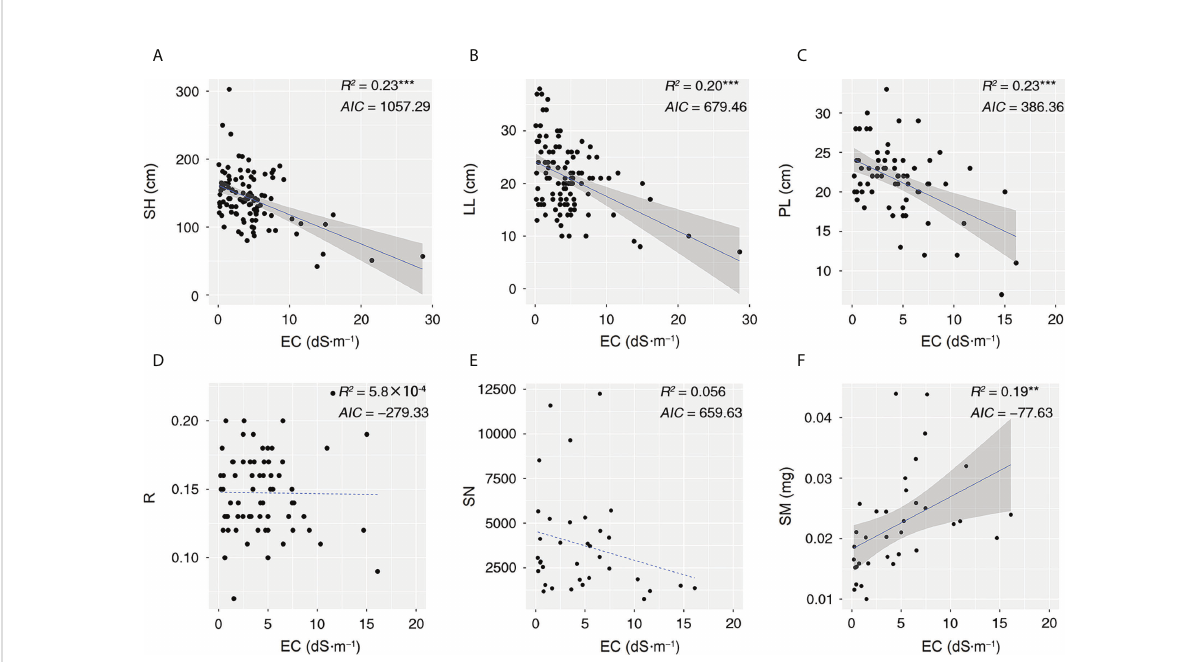
FIGURE 3 Relationships between Phragmites australis traits (A , shoot height; B , leaf length; C , panicle length; D , reproductive allocation, i.e. the ratio of panicle length to shoot height; E , seed number per panicle; F , mass per seed ) and soil electrical conductivity across fi ve populations based on general linear models. ** P < 0.01; *** P <